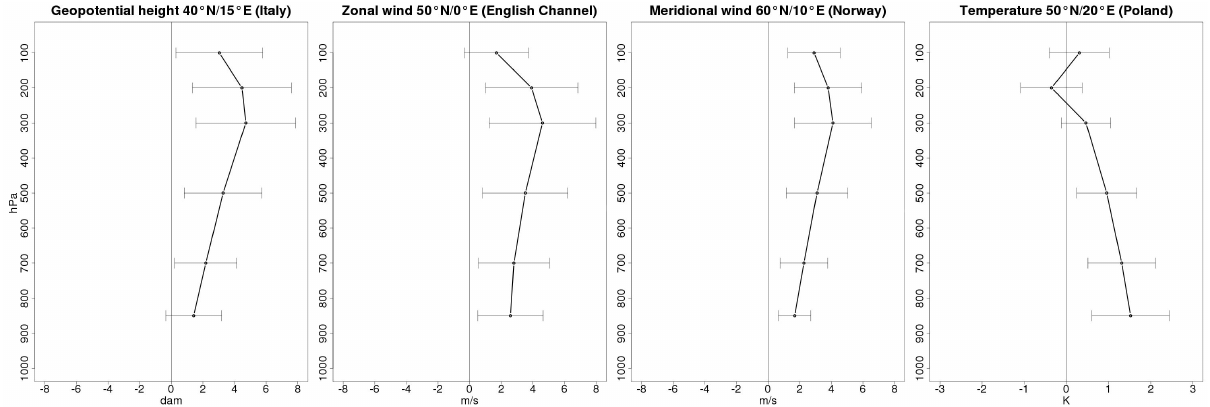
Fig. 12. Vertical profiles of the composites difference at four specific grid points (one grid point for each available variable). Error bars represent the 95% confidence intervals.